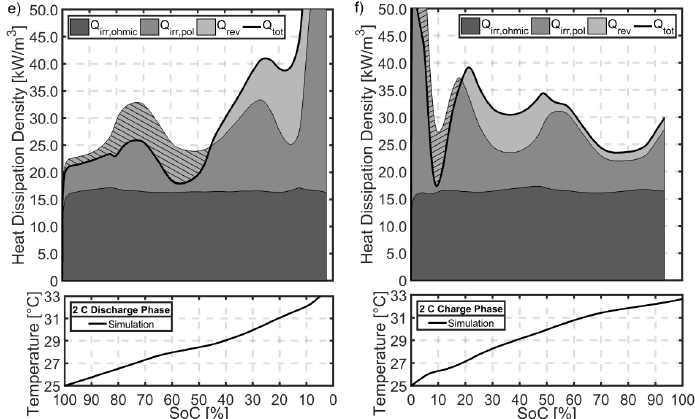
Figure 8. Simulated heat dissipation density profiles (kW/m 3 ) of the cell as a function of cell SoC (%) during a discharge and charge phase at: ( a , b ) 0.5 C, ( c , d ) 1 C, and ( e , f ) 2 C current rates. The simulated cell temperature profile ( °C ) is shown for comparison in each case.